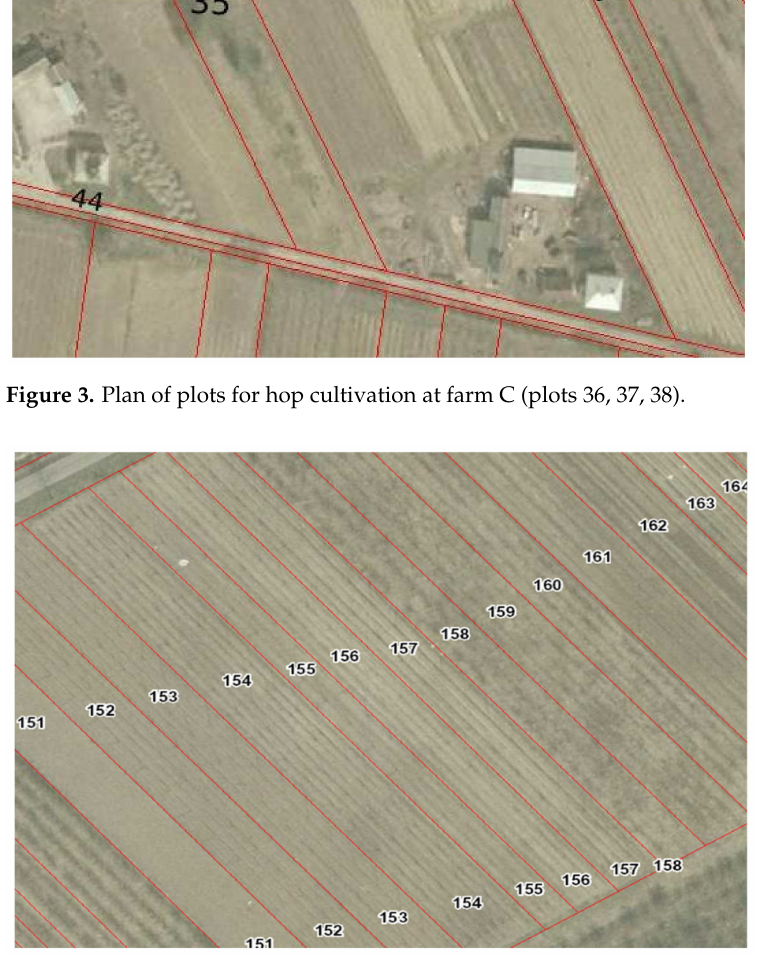
Figure 4. Plan of plots for hop cultivation at farm D (plots 155, 156,